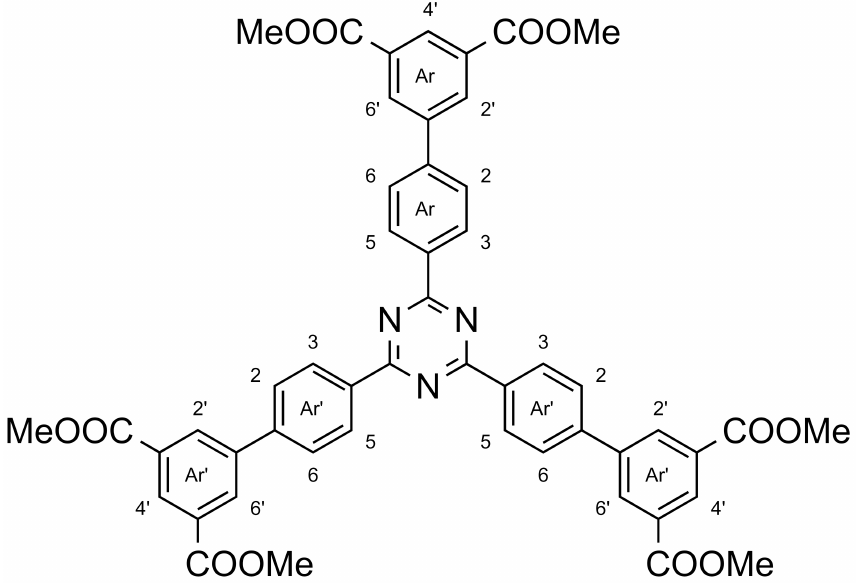
Under nitrogen, a solution of 2,4,6-tris(4-bromophenyl)-1,3,5-triazine ( 3a , 803 mg, 1.47 mmol) [20], dimethyl 5-(4,4,5,5-tetramethyl-1,3,2-dioxaborolan-2-yl)-isophthalate ( 4 , 1.69 g, 5.28 mmol), (cid:48) potassium acetate (1.30 g, 13.2 mmol), and 1,1 -bis(diphenylphosphine)ferrocene-palladium(II) chloride (120 mg, 164 µ mol) in a 10:1 mixture (90 mL) of 1,4-dioxane and water was heated to reflux for 48 h. After evaporation of the dioxane, deionized water (100 mL) was added, and the aq. layer was extracted with chloroform (3 × 100 mL). The combined organic extract was washed with brine (100 mL), dried with magnesium sulfate, and filtered. Activated charcoal was added, and the mixture was heated and filtered while hot. After reduction of the volume, the crude product was recrystallized from chloroform / petrol ◦ ether, yielding 1.14 g (1.29 mmol, 88%) of a colorless solid. M. p.: > 300 C. 1 H NMR (600 MHz, CDCl 3 ): δ = (cid:48) (cid:48) (cid:48) 8.88 (m c (d), 6 H, J = 8.1 Hz, Ar- H -3,5), 8.69 (s, 3 H, Ar- H -4 ), 8.56 (s, 6 H, Ar- H -2 ,6 ), 7.87 (m c (d), 6 H, J = 8.1 Hz, Ar- H -2,6), 4.01 (s, 18 H, CO 2 C H 3 ) ppm. 13 C NMR (150 MHz, CDCl 3 ): δ = 171.2 (s, tri- C -2,4,6), 166.1 (s, C O 2 Me), 142.9 (s, Ar- C -1), 141.1 (s, Ar- C -1 (cid:48) ), 136.0 (s, Ar- C -4), 132.4 (d, Ar- C -2 (cid:48) ,6 (cid:48) ), 131.3 (s, Ar- C -3 (cid:48) ,5 (cid:48) ), 129.9 (cid:48) (d, Ar- C -4 ), 129.7 (d, Ar- C -3,5), 127.4 (d, Ar- C -2,6), 52.6 (q, CO 2 C H 3 ) ppm. MS (MALDI, Cl-CCA): m / z = + 886 [M + H] . IR (ATR): (cid:101) ν = 3005 (aryl-H), 2993 (C-H-val.), 1690 (C = O), 1609, 1581, 1509 (arom. C = C, arom. − 1 C = N), 1435 (CH-def.), 1349 (C-N-val.), 813 (1,4-disubst. aryl, 1,3,5-trisubst. aryl) cm . Elemental analysis (C 51 H 39 N 3 O 12 ) (885.87): calcd. C 69.15 H 4.44 N 4.74; (C 51 H 39 N 3 O 12 · 0.1 CHCl 3 ) (897.81): calcd. C 68.36 H 4.39 N 4.68; found C 68.26 H 4.28 N